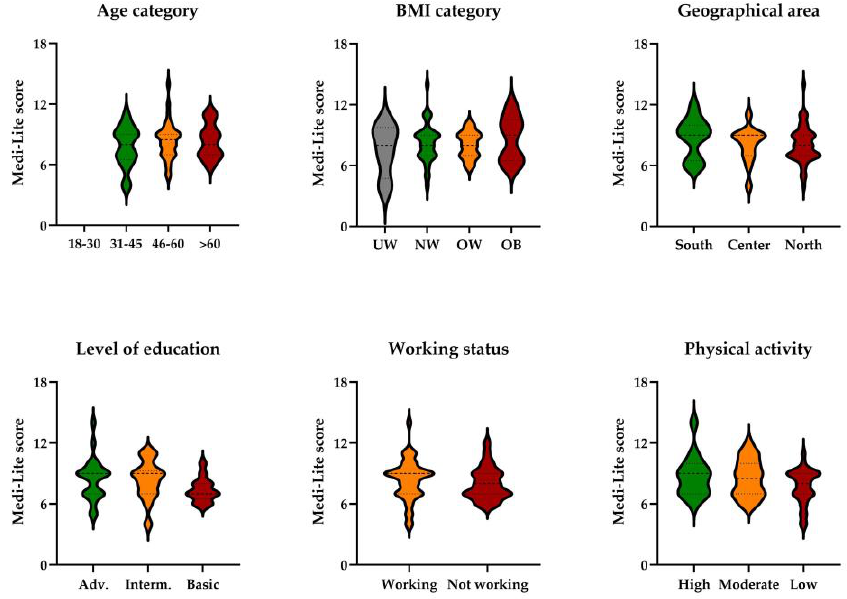
Figure 3. MEDI-LITE score by age category, body mass index (BMI) category, geographical area, level of education, working status, and physical activity level in participants on dialysis. UW, un- derweight; NW, normal weigh; OW, overweight; OB, obesity; Adv, advanced; Interm., intermedi- ate.